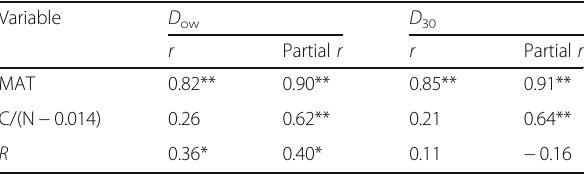
Statistical significance indicated by * ( p <0.05) and ** ( p